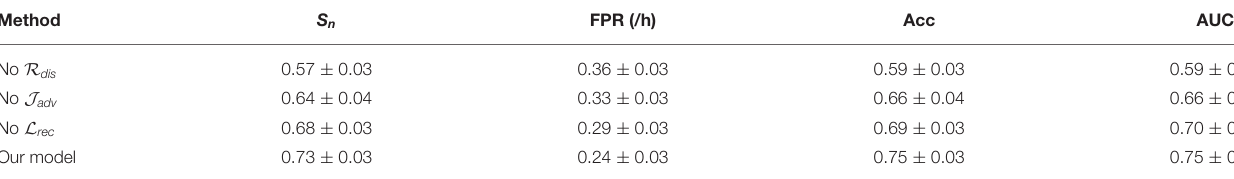
TABLE 8 | Comparison results on the CHB-MIT database using various components.